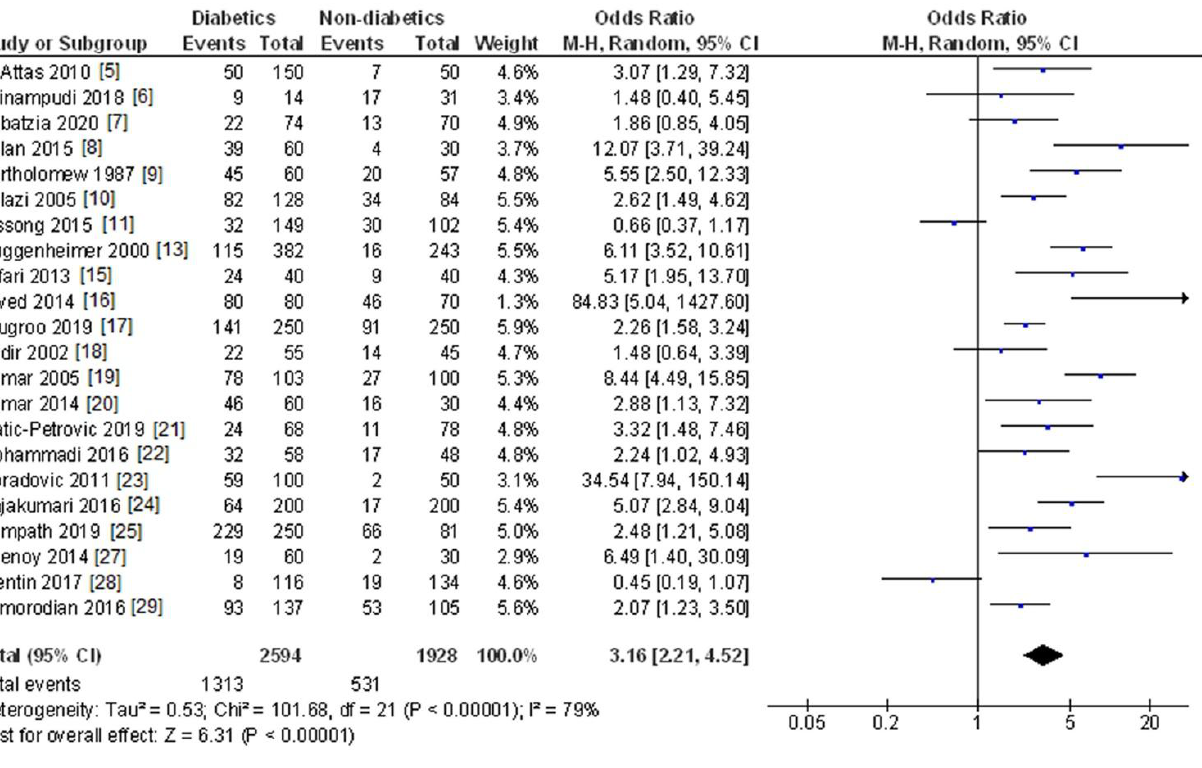
Figure 2 : Study data and forest plot graph for the Candida species detection in subjects with and without diabetes